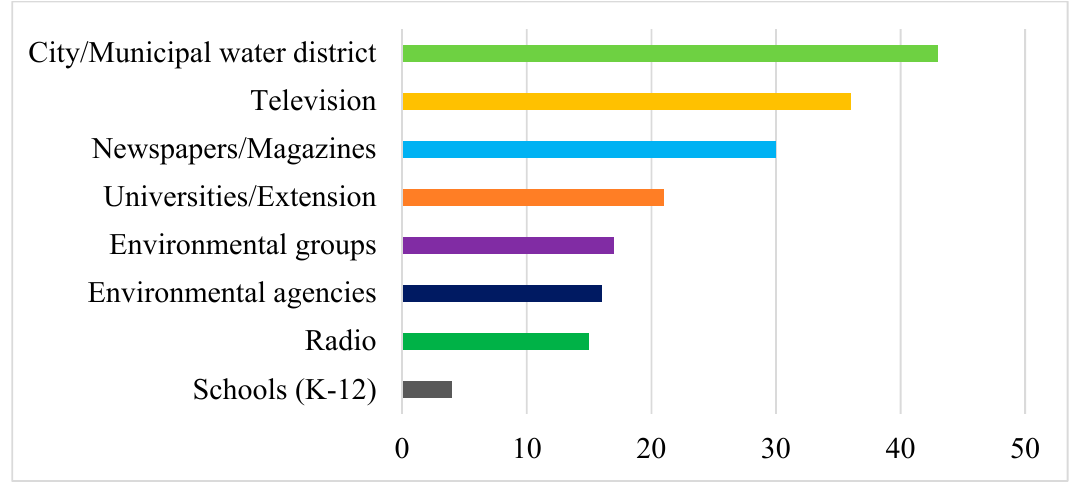
Figure 1. Percent of responses about water resource information sources.